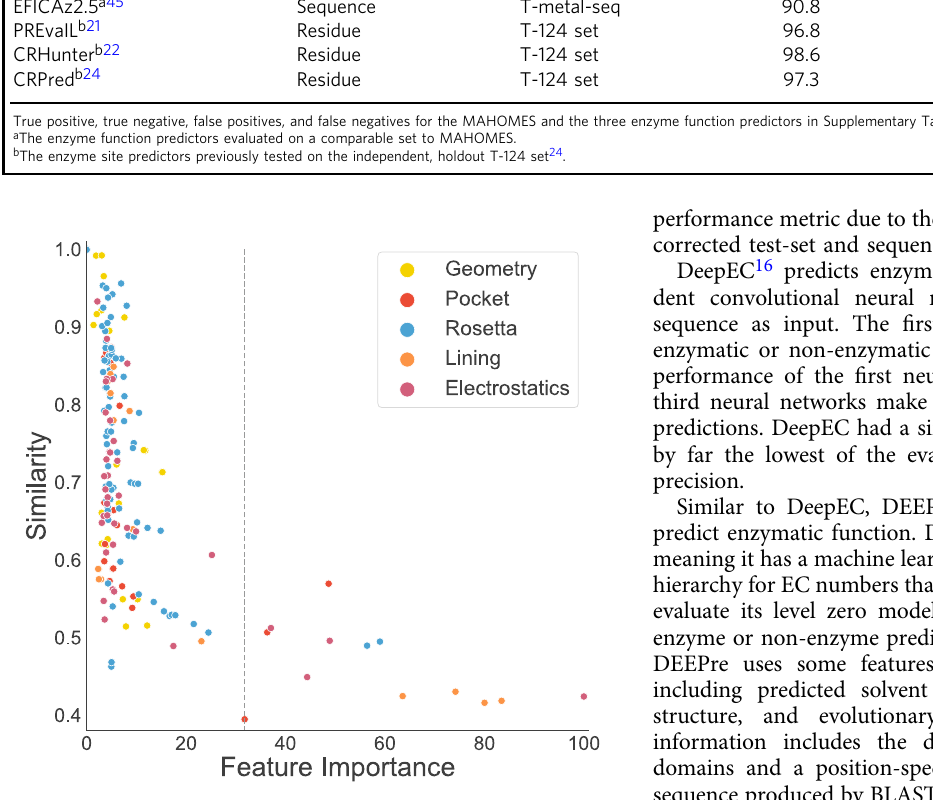
Fig. 4 Feature similarity with respect to feature importance. Each point represents a feature and is colored according to the feature category: geometry features are yellow, pocket features are red, Rosetta features are blue, lining features are orange, and electrostatic features are purple. The y - axis is the similarity calculation for the enzymatic and non-enzymatic feature values (see methods for more detail). The x -axis is the features importance for MAHOMES (see methods for more detail). The dashed line indicates the feature importance of volume. See Supplementary Data 1e for values and feature